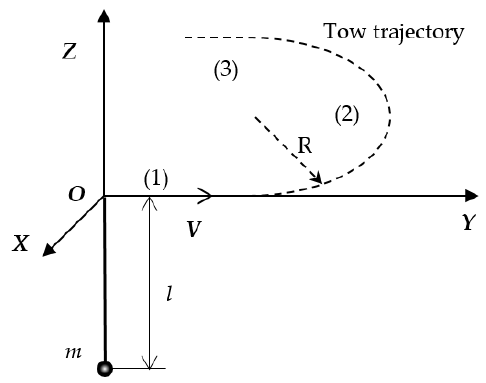
Figure 6. Sketch of U-turn cable-towed system.